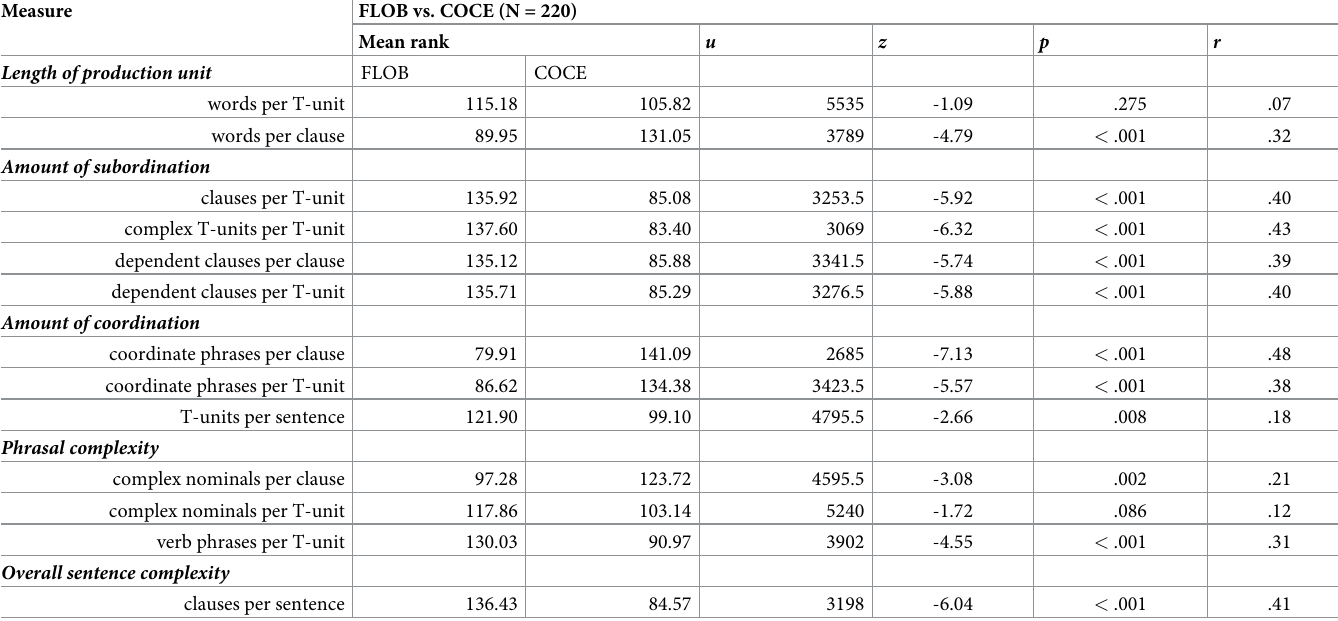
Table 8. Mann-Whitney tests on syntactic complexity between FLOB academic writing and COCE academic